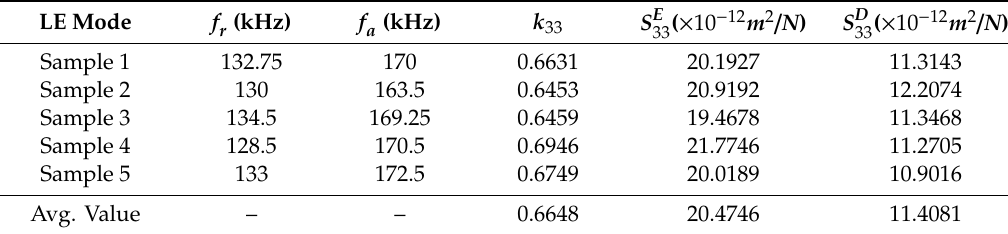
Table 5. Resonant and anti-resonant frequencies and the converted material constants in length extension (LE) mode.